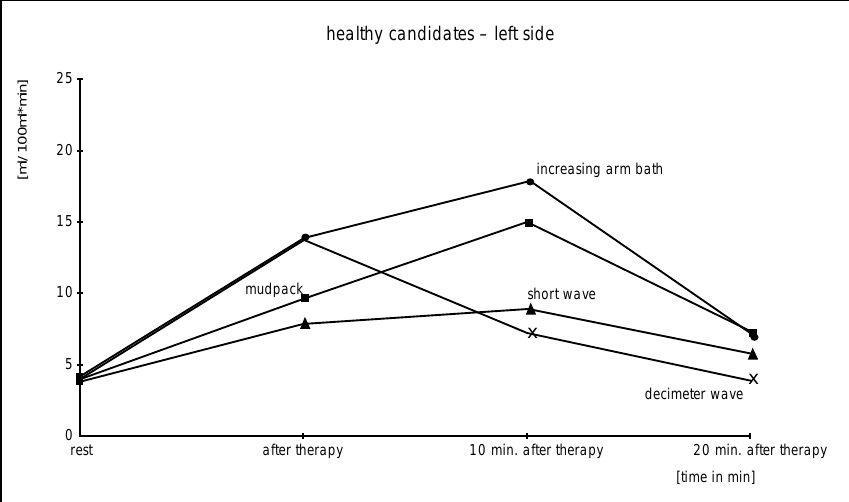
Figure 4: Consensual blood flow reaction in the contralateral forearm after the individual thermotherapies in the healthy references groups (n =